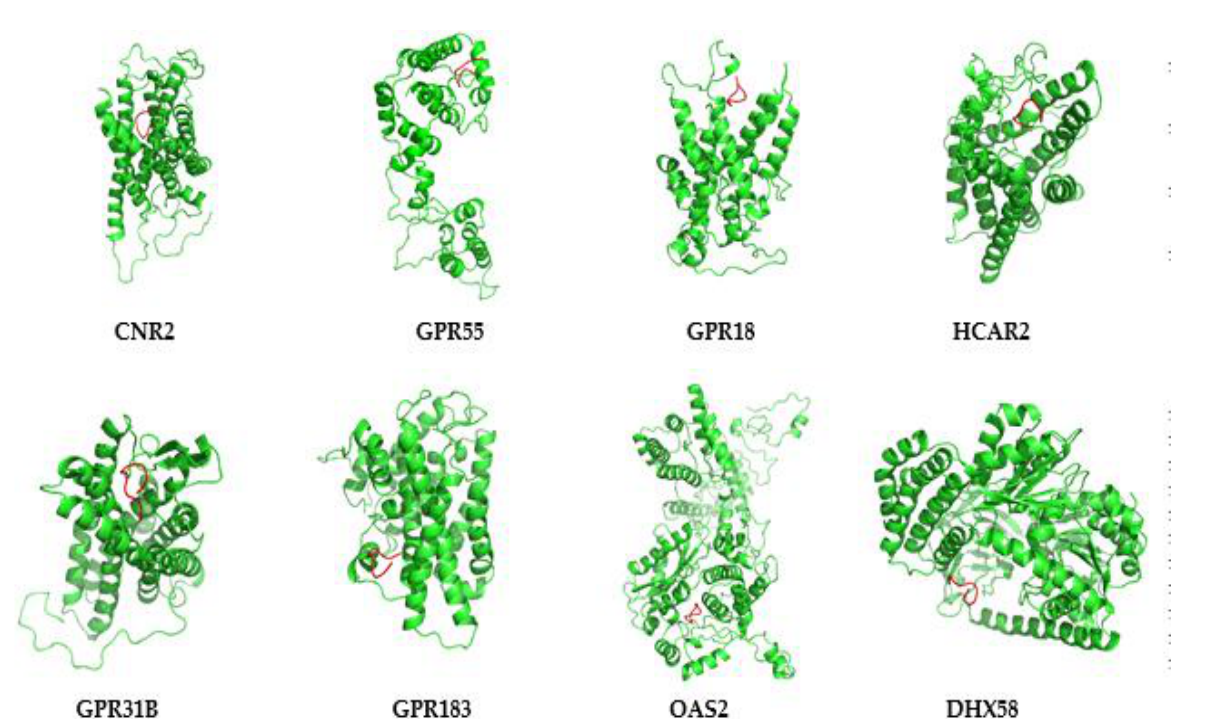
Figure 9. The docking analysis of NPFF and hub proteins. There dimensional structures of NPFF (red)-hub proteins (green) were presented, including CNR2, GPR55, GPR18, HCAR2, GPR31B, GPR183, OAS2, and DHX58. The picture was generated using the Pymol software (Delano, W.L. The Pymol Molecular Graphics System (2002) DeLano Scientific, SanCarlos, CA, USA. http://www.pymol.org, accessed on 11 November 2020).